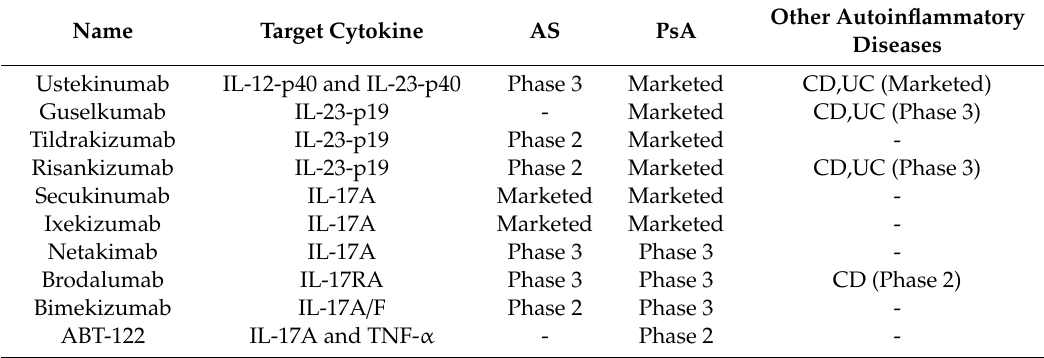
Table 1. Agents targeting IL-23 / IL-17